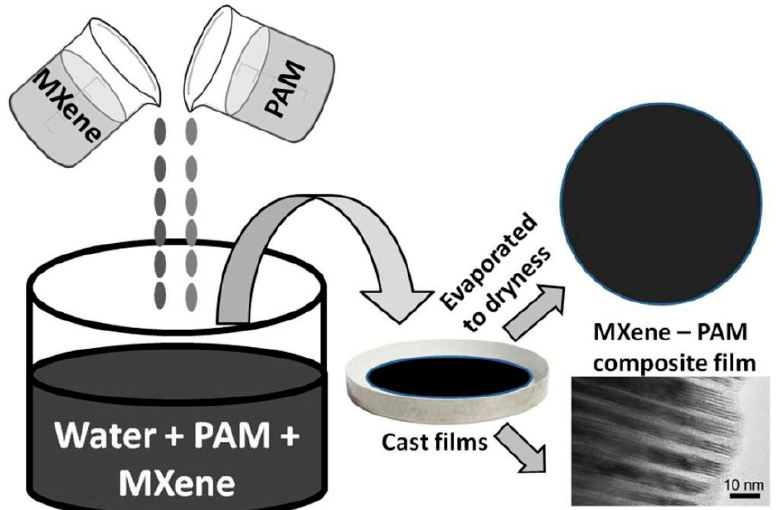
Figure 5. Schematic of the synthesis of MXene-Polyacrylamide nanocomposite films by the solution mixing method. Reprinted with permission from Ref. [40]. 2016, RSC Publishing.